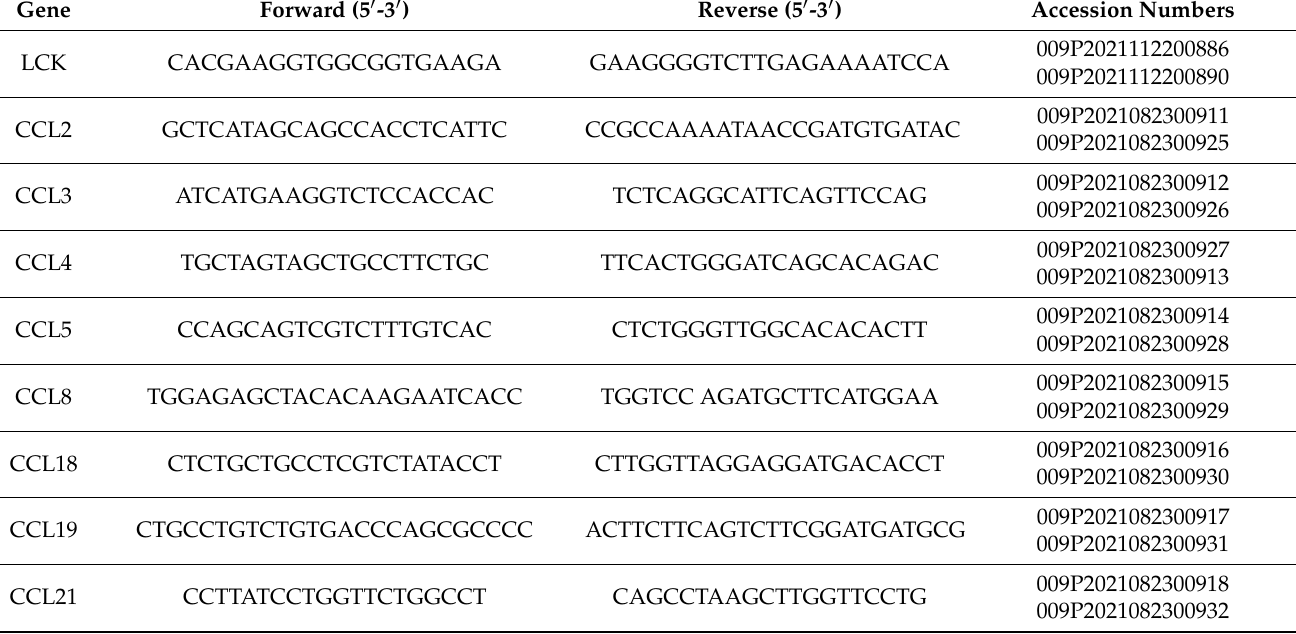
Table 1. Primer sequences used in quantitative real-time polymerase chain reaction (qRT–PCR). Gene Forward (5 (cid:48) -3 (cid:48)